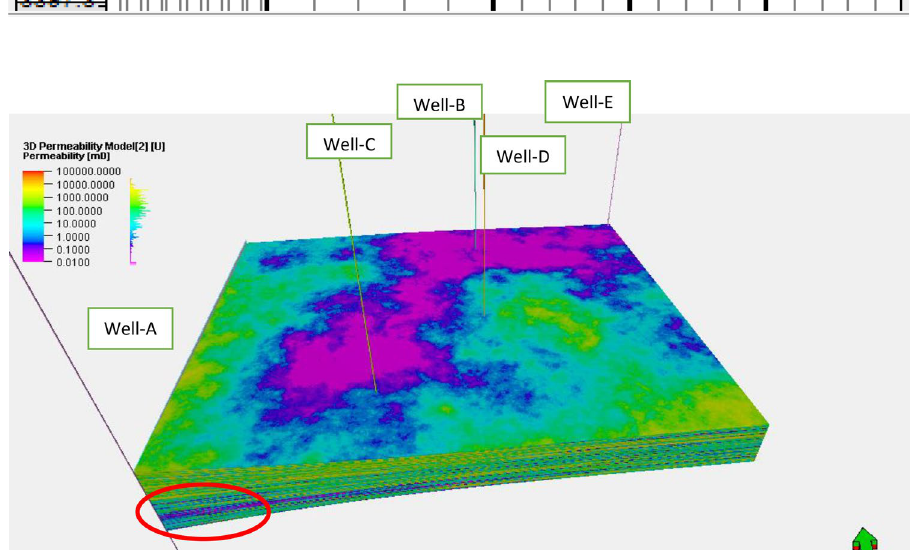
Fig. 17 3D permeability model of the studied